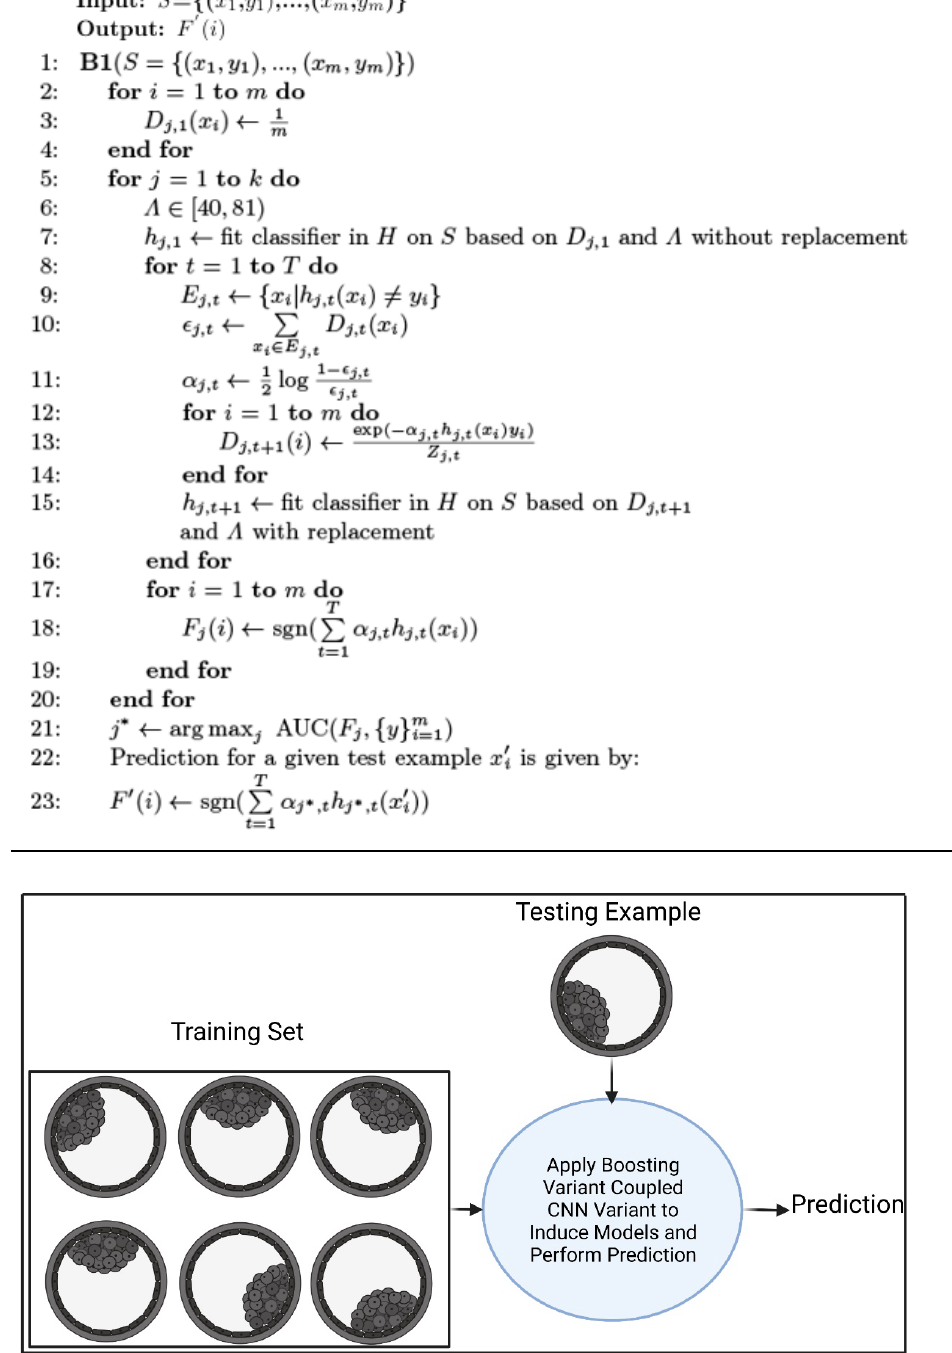
Figure 5. The first boosted deep learning approach (B1DL) for predicting the quality of embryos. Figure created with